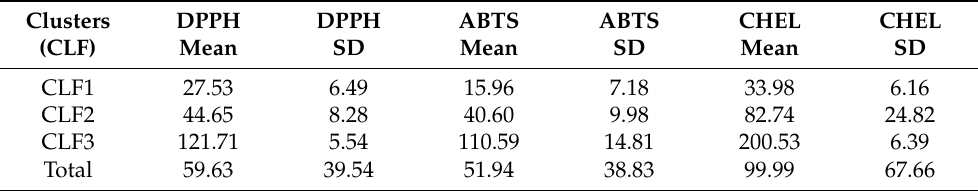
Table 9. Belonging to clusters (CLF) n = 8 of antioxidant activity tests.